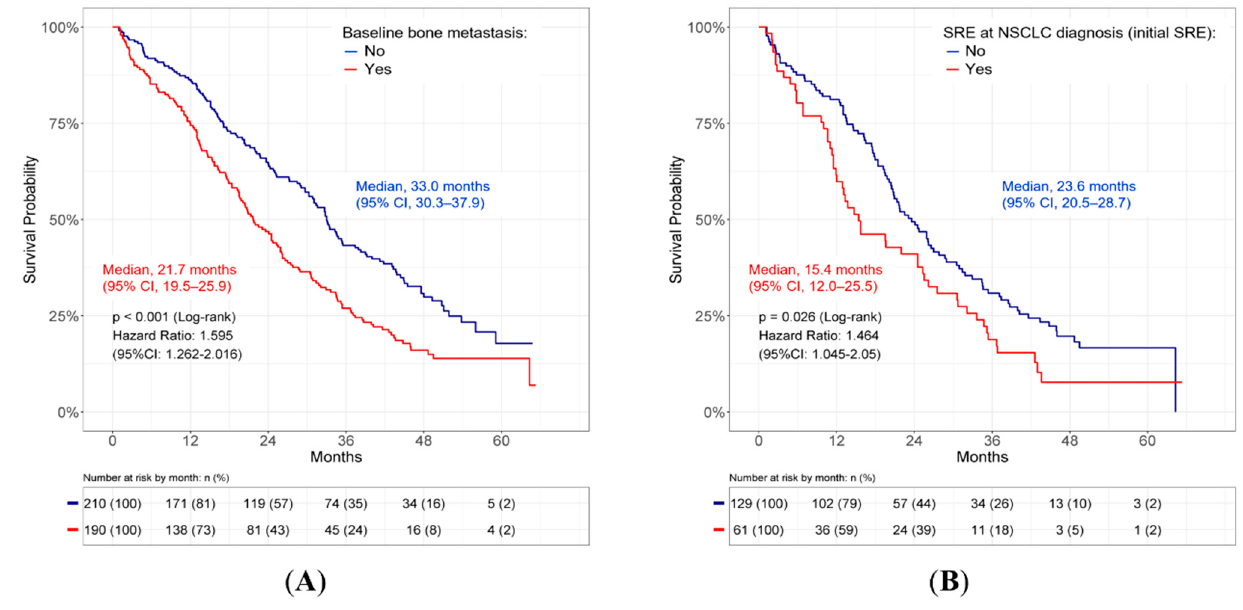
Figure 2. OS in ( A ) metastatic EGFR -mutated NSCLC patients with or without baseline bone metastasis and ( B ) bone metastatic patients with or without SRE at NSCLC diagnosis (initial SRE). CI, confidence interval; EGFR : epidermal growth factor receptor; NSCLC: non-small cell lung cancer, OS: overall survival; SRE: skeletal-related event.